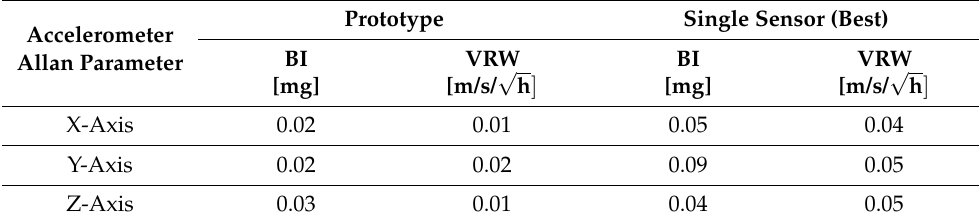
Table 3. Accelerometer parameters estimated through Allan